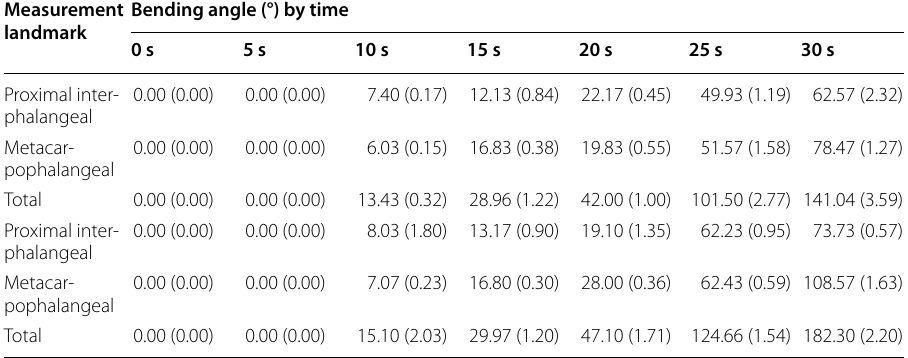
Data are expressed as Mean (SD) SD standard deviation